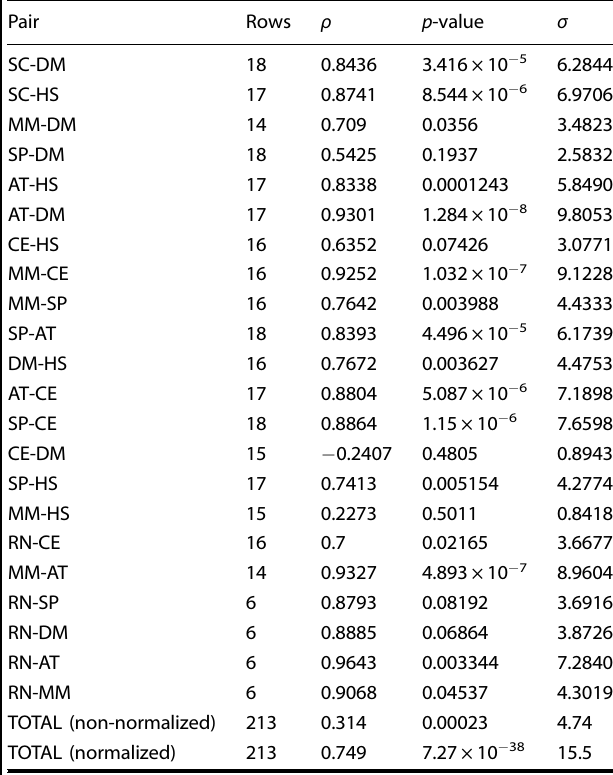
Each row represents one species pair with the NAF-precision correlation across all measures. The second-last row is the correlation between NAF and prediction precision across all species and all measures. However, as seen in Table 2, the scaling between NAF and precision can differ substantially across species, which muddles the correlation. We correct for this in the fi nal row, where we have normalized the NAF and precision to their maximum values on a per-species